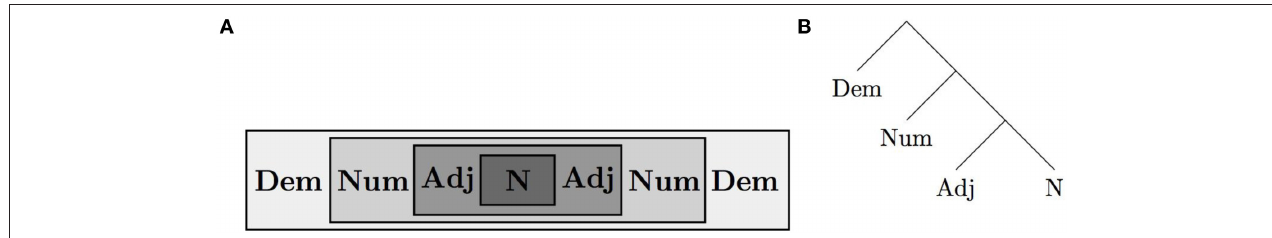
FIGURE 5 | Nested representation (A) and hierarchical representation (B) of semantic relations between modifiers and the noun. The most typologically common orders can be read off directly.